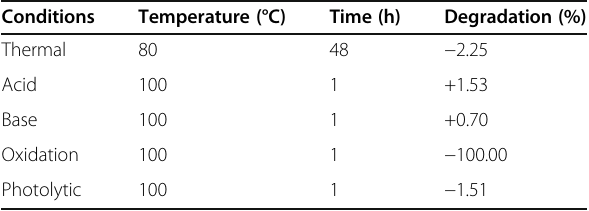
Table 2 Summary of degradation